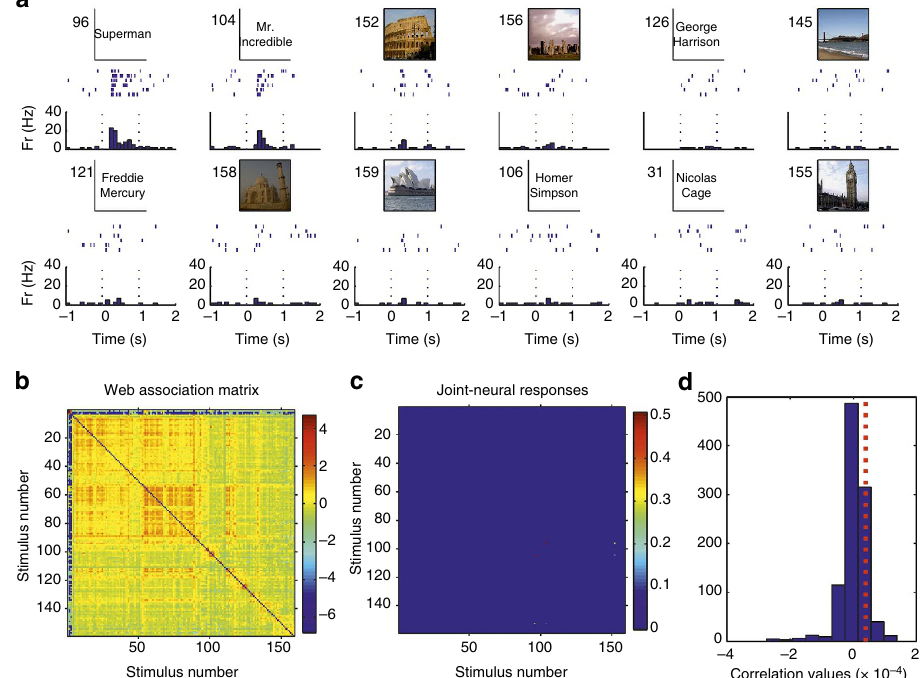
Figure 8 | Correlation analysis with a neuron in the entorhinal cortex. ( a ) A single neuron in the entorhinal cortex that fired to pictures of two cartoons, Superman and Mr. Incredible, but not to other cartoons, like Homer Simpson (stimulus 106). ( b , c ) Web-association and joint-neural response matrices (see text for details). Colour bars on the right denote association and join-response strength, respectively, in arbitrary units. ( d ) Correlation between the web- association and joint-response matrices (red dotted line) and for a distribution of 1,000 surrogates. In this case, the correlation between the web- association and the joint-response matrices was not significant ( P ¼ 0.13, rank test, 1,000 surrogates) due to the fact that the neuron encoded relatively few of the associations in the web-association matrix.